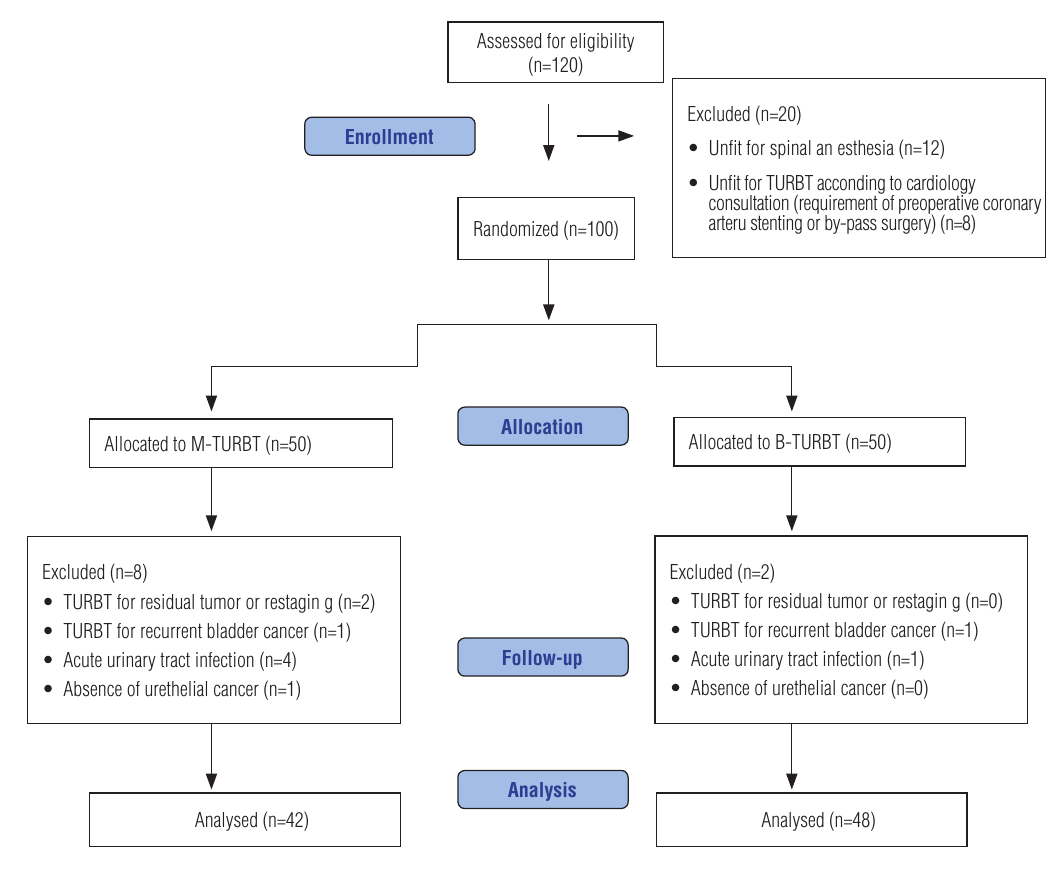
figure 1 - cONSORT (consolidated Standards for Reporting Trials) flow diagram for patient assessment, allocation, follow-up and